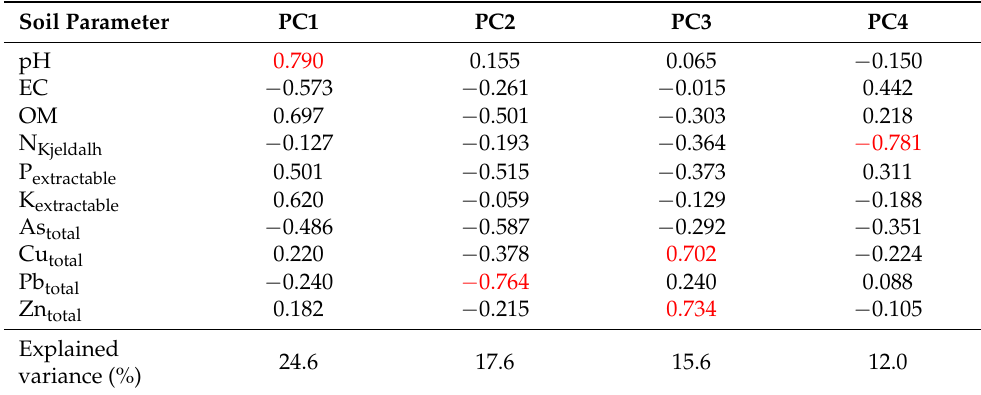
Table 2. Factor loadings of each soil parameter along the first four principal components, PC1, PC2, PC3, and PC4, which resulted from the PCA. Marked correlations, in red, are significant (correlation coefficient > 0.7).